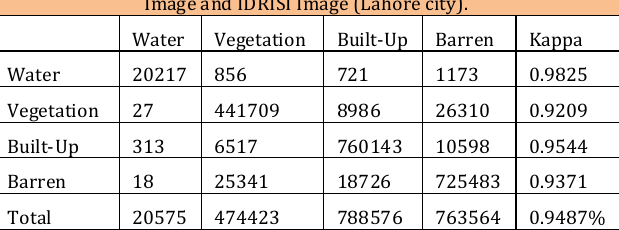
Figure 3: Transition of each LULC Class from 1998-2018 Table 6: Overall, the Kappa Statistic between each Class of Original Image and IDRISI Image (Lahore city).